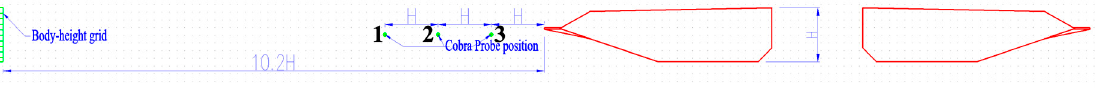
Figure 7. Locations of the Cobra Probe.